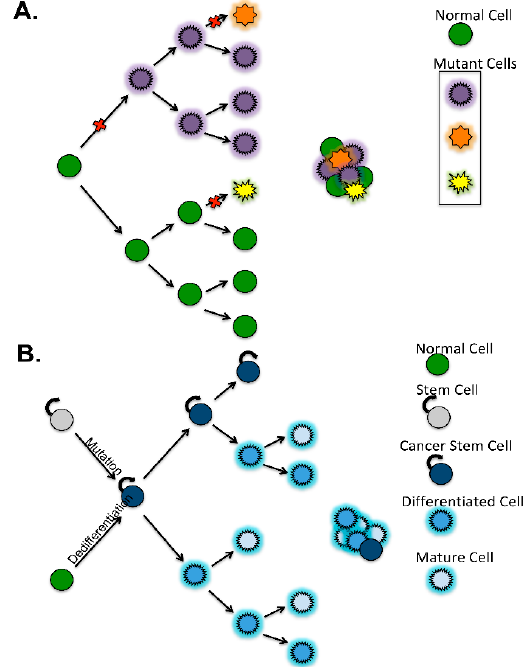
Figure 3. Models of tumor development and heterogeneity. ( A ) The clonal evolution model for